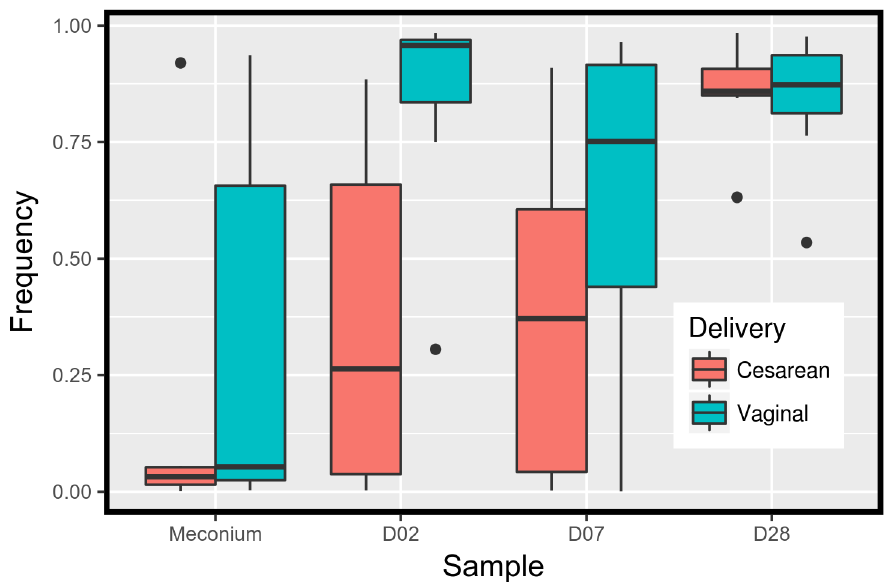
Fig 5. Relative abundance of strictly anaerobic bacteria in the infants’ samples according to the sampling day and delivery mode (Cesareansections versus vaginal delivery).